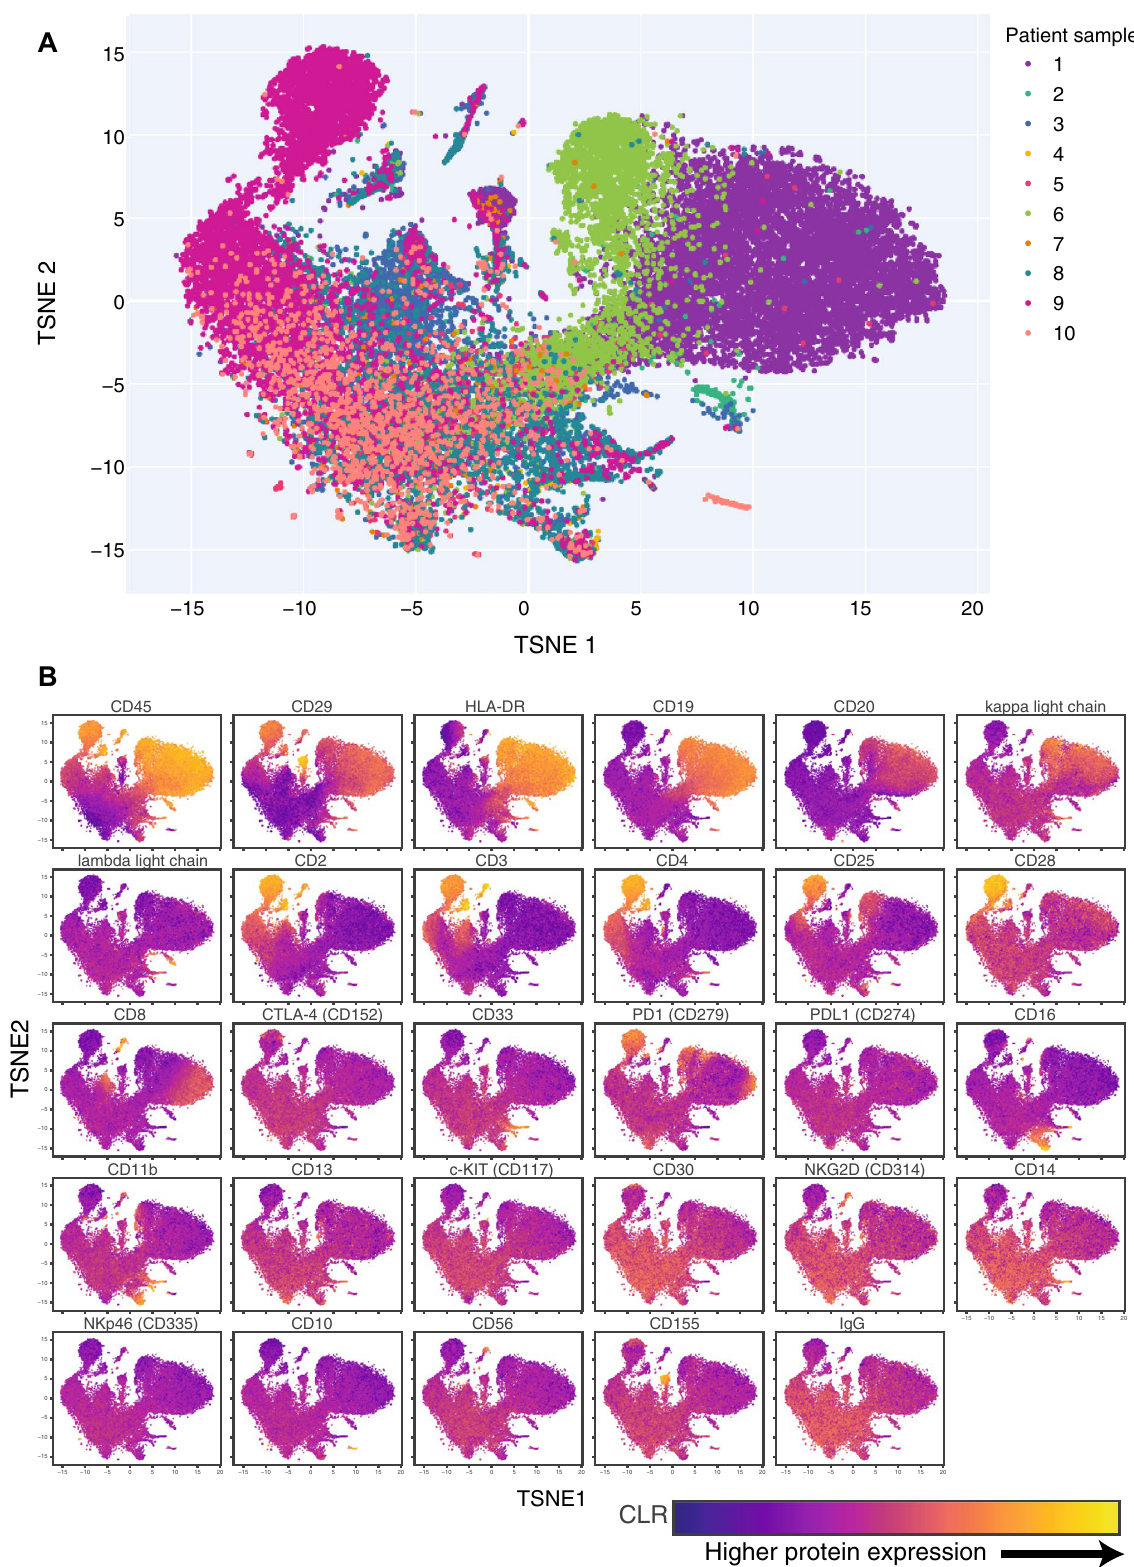
Figure 3. Two dimensional TSNE visualization of pooled patient cell samples. ( A ) Individual cells identified in split pool demultiplexing from 10 pooled patient samples. All cells from a given patient are colored the same. ( B ) Two dimensional TSNE of pooled patient samples, color-coded by CLR-transformed protein scores for all 29 proteins sampled. Color scales are normalized for each individual protein to show maximal dynamic